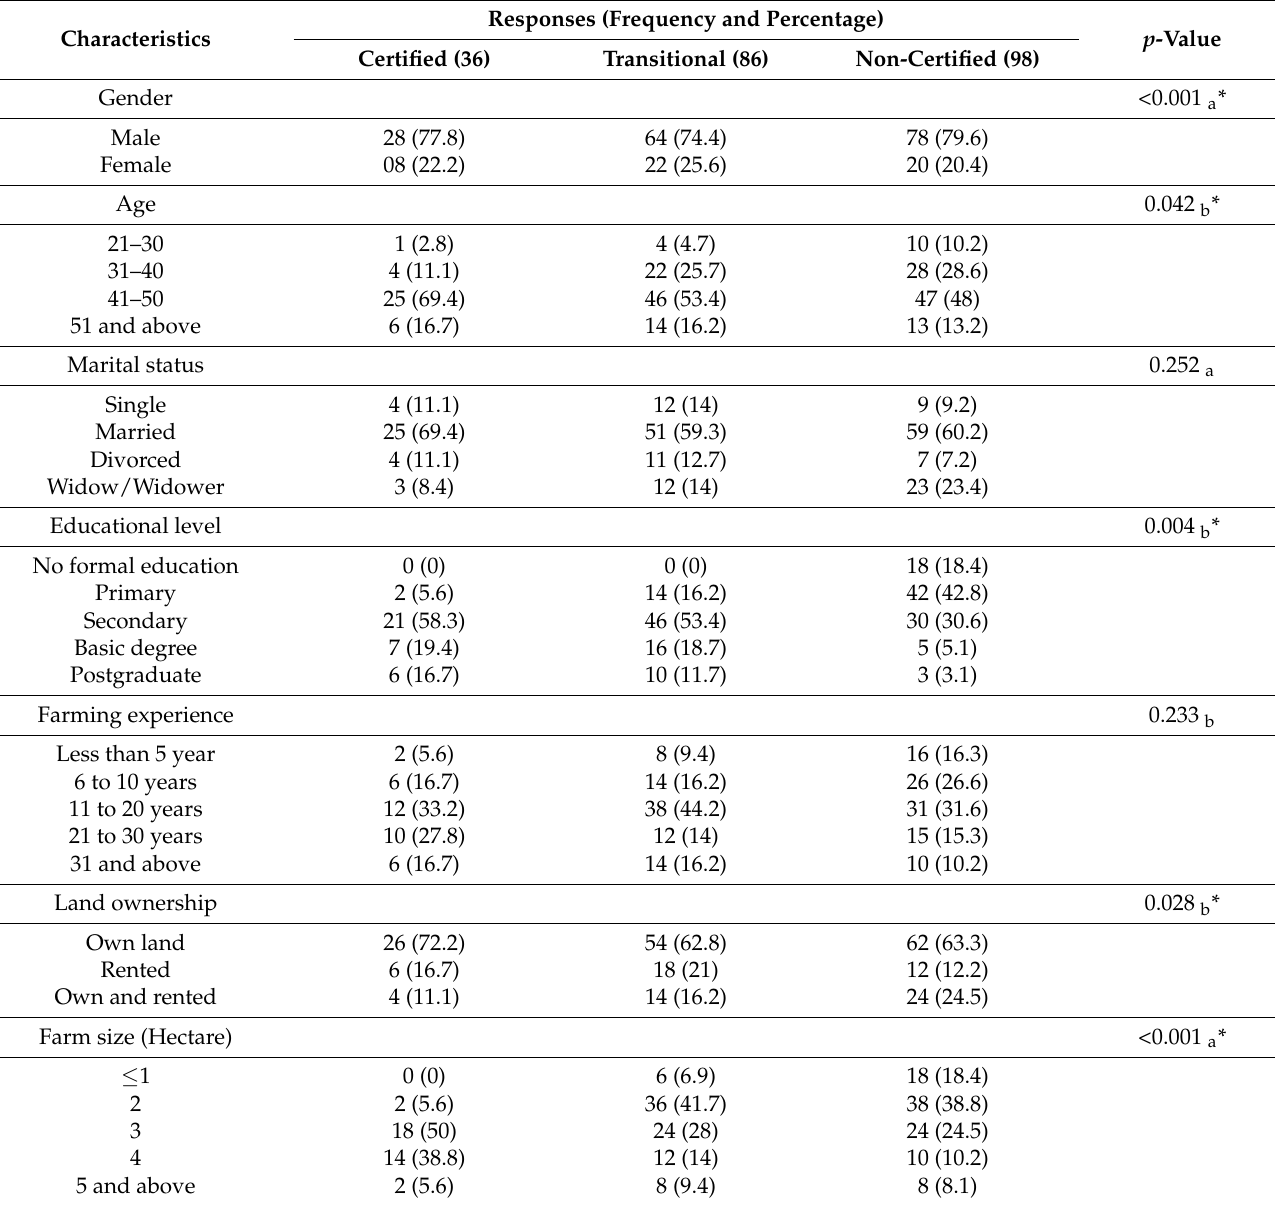
Table 1. Socio-economic and demographic status of the